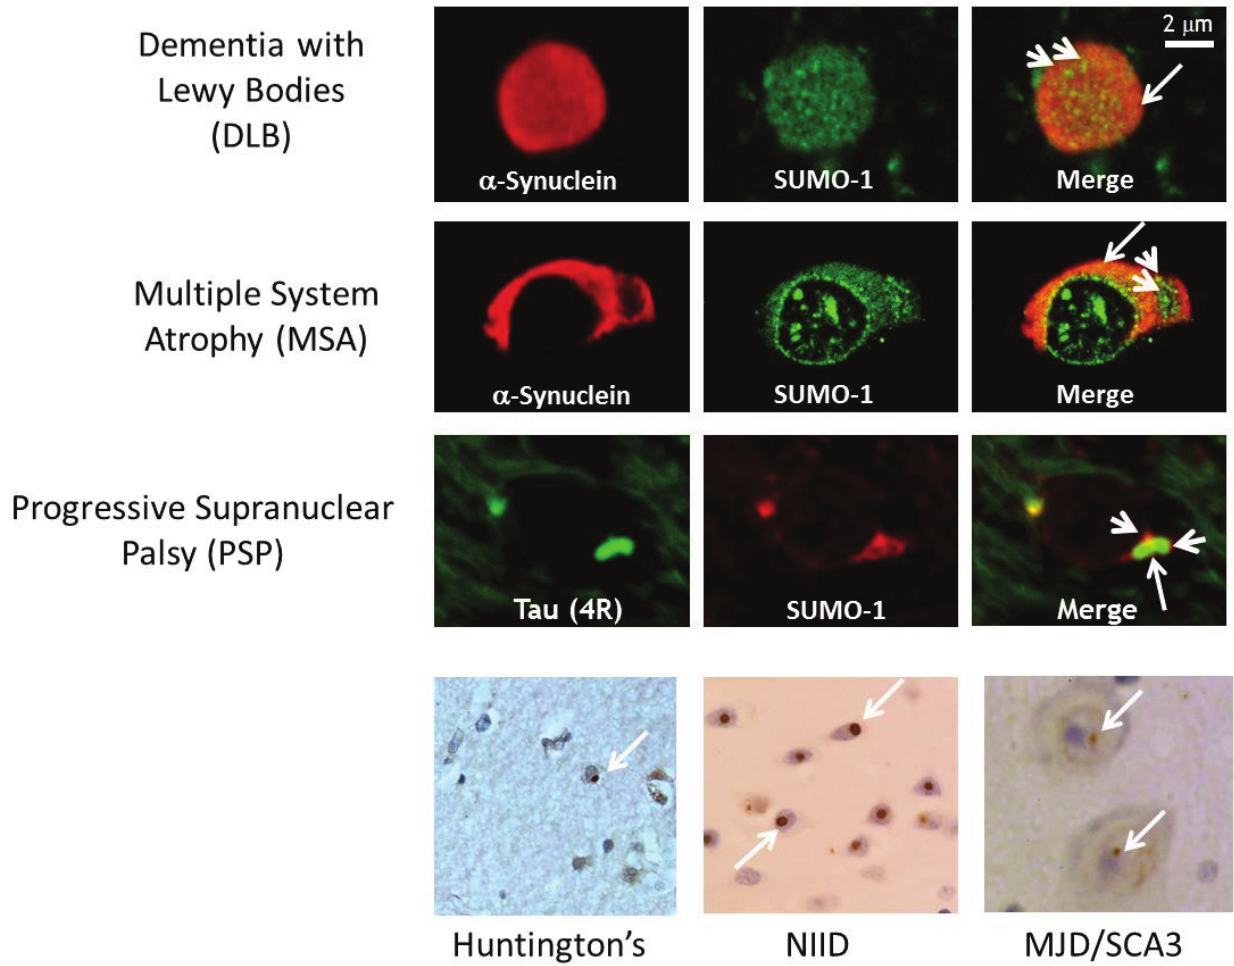
Figure 2. SUMO-1 is found in both intracytoplasmic and intranuclear protein inclusion bodies in neurodegenerative diseases. ( top ) Immunofluorescence of isolated Lewy bodies from dementia with Lewy bodies brain tissue (arrow) contain punctate SUMO-1 immunopositive domains (arrowheads). Multiple system atrophy glial cytoplasmic (cid:2)-synuclein inclusion (GCI, arrow) body with associated nucleus shows SUMO-1 domains (arrowheads) surrounding the aggregated (cid:2)-synuclein (For details see [26]). Progressive supranuclear palsy perinuclear glial tau inclusion bodies (large arrow) are decorated with SUMO-1 domains (arrowheads) (For details see [24]). ( Bottom ) Intranuclear neuronal inclusion bodies (arrows) in Huntington’s disease and spinocerebellar ataxias (NIID, MJD/SCA3) immunostain intensely for SUMO-1 (For details see